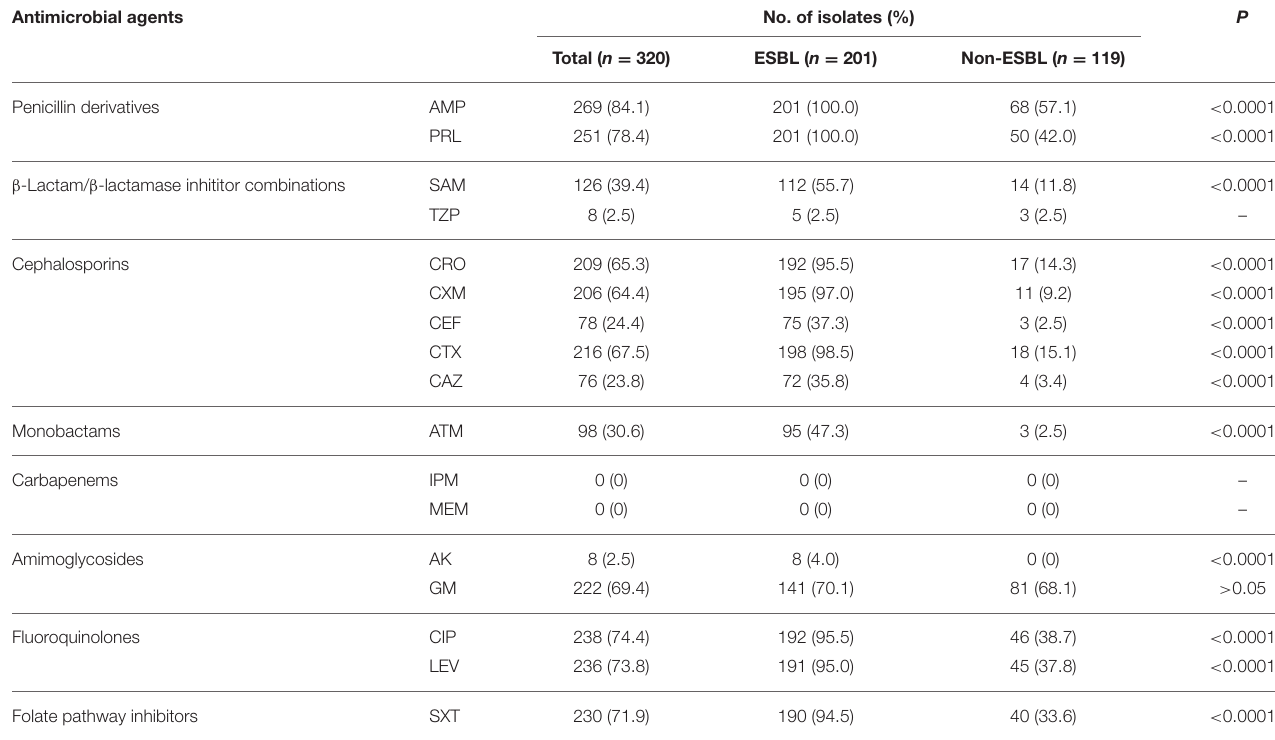
TABLE 1 | Rates of antimicrobial resistance among E. coli isolates. Antimicrobial agents